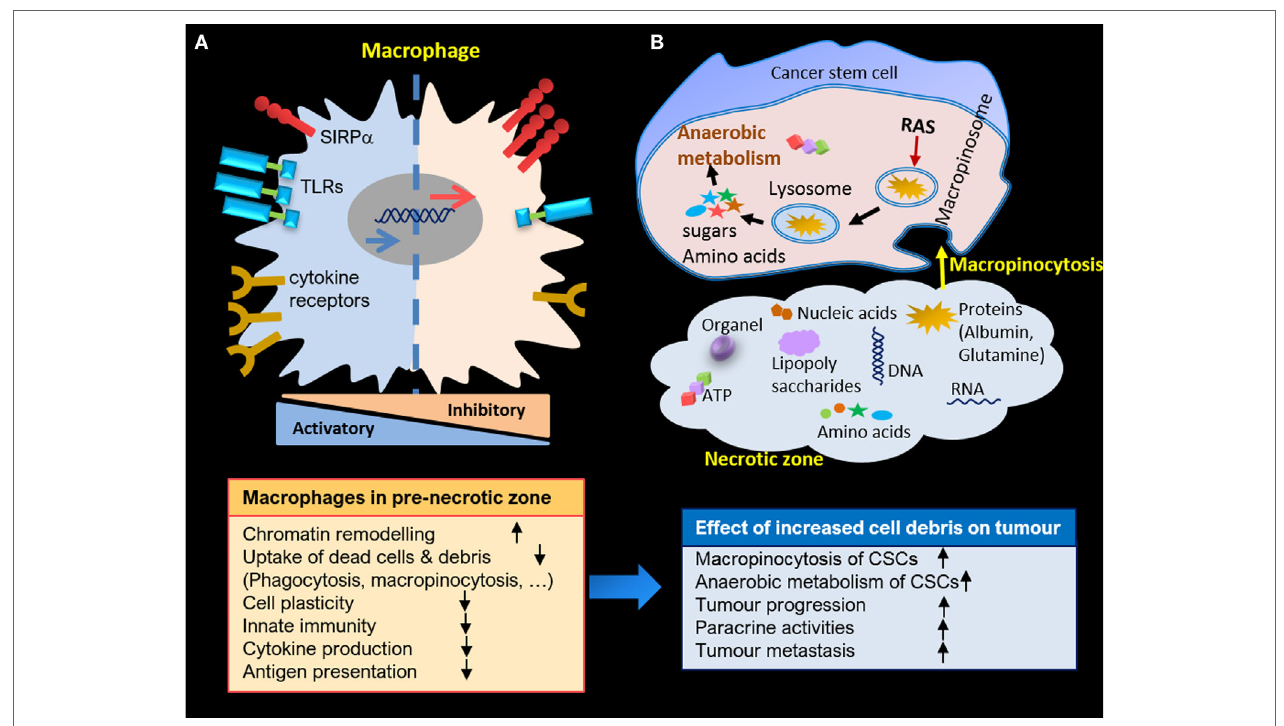
FigUre 2 | (A) Macrophage alteration in pre-necrotic zone and gradual loss of activities due to continuous exposure to cell debris. (B) Anaerobic metabolism of cancer stem cells (CSCs) in necrotic zone through macropinocytosis, and enhanced proliferation and paracrine activities of CSCs due to accumulation of cell debris in necrotic